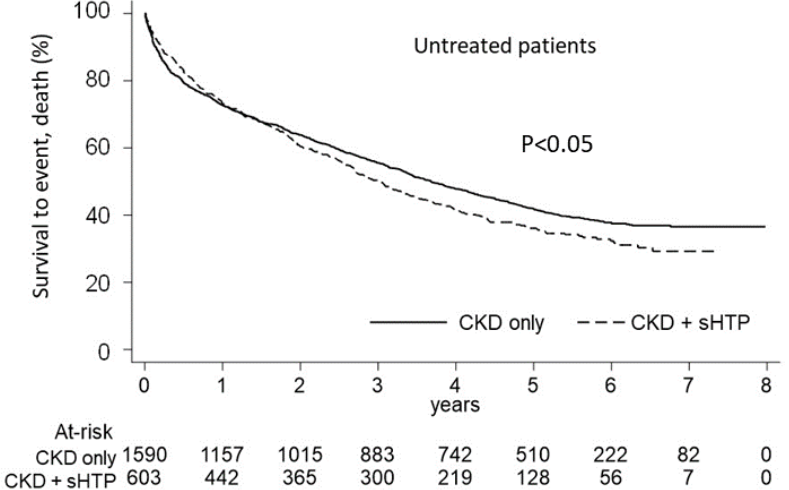
Figure 6. Kaplan-Meier curves for the CKD + sHPT vs. CKD-only groups showing overall survival in untreated patients.